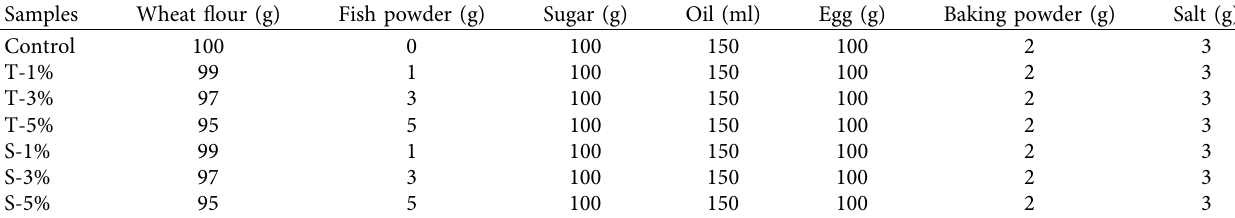
Table 1: Ingredients required for cake formulation.